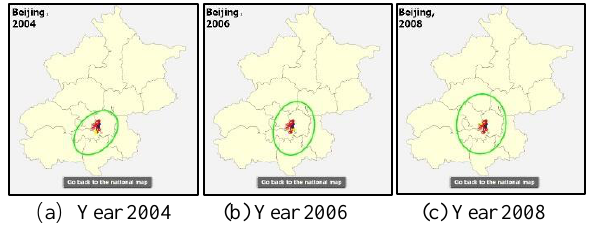
Figure 9. The standard deviational ellipses of social service industry in Beijing for year 2004, 2006 and 2008 respectively